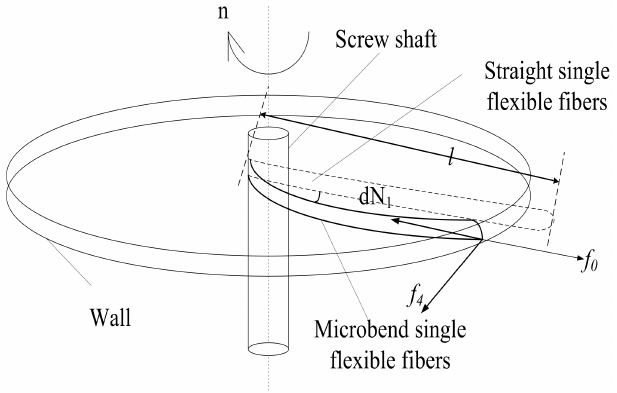
Figure 8. Stress analysis of the elastic deformation of the flexible spiral